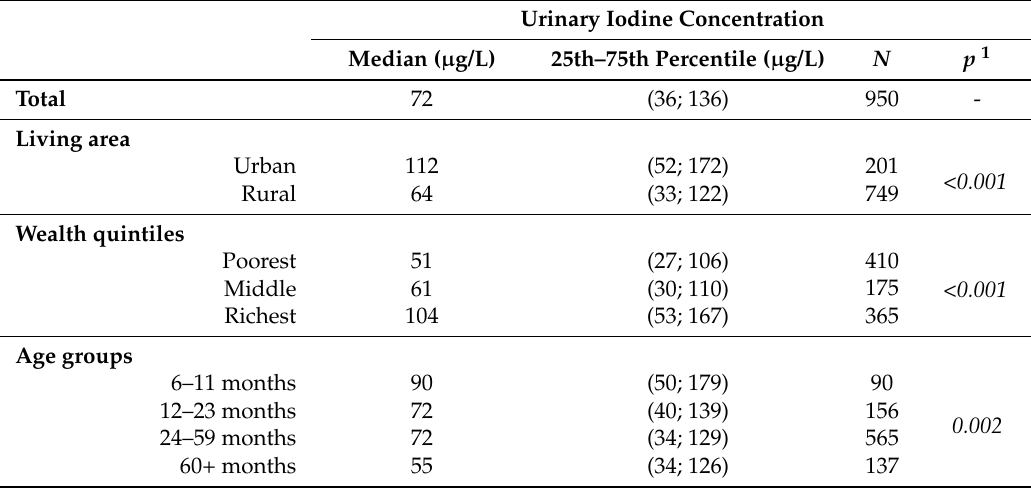
Table 3. Bivariate relationships between median UIC and living area, wealth quintiles, age groups, access to iodized salt, and access to equity card among children under 5 years of